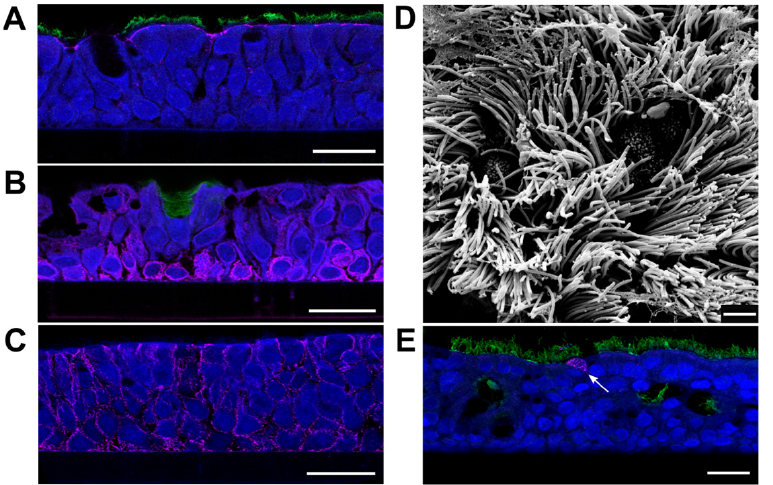
Figure 1. Characterization of PBEC-ALI cultures using cell markers and electron microscopy and susceptibility to NiV infection. ( A ) Immunostaining of cross sections for β -tubulin (ciliated cells; green) and ZO-1 (tight junctions; magenta), ( B ) mucin-5AC (mucus secreting cells; green) and cytokeratin 5 (basal cells; magenta), and ( C ) β -catenin (cell adherens junctions; magenta). ( D ) Scanning electron microscopy visualization of fully-differentiated PBEC-ALI culture after 4 weeks of ALI cultivation. ( E ) Immunostaining for β -tubulin (green) and NiV nucleoprotein N (magenta) at 2 dpi. Arrow: NiV infected cell. Scale bars: 20 µm ( A – C , E ) and 2 µm ( D ).